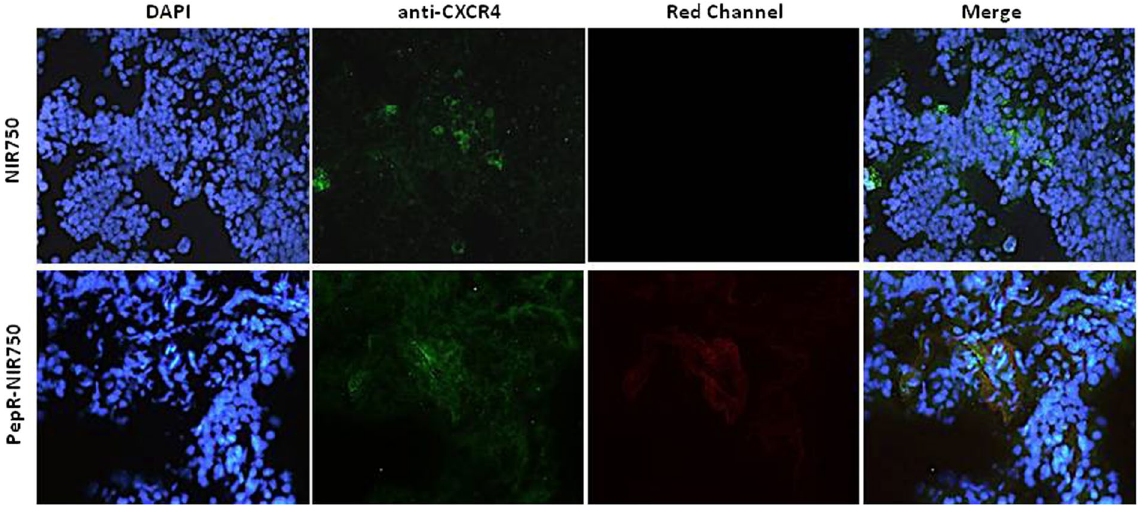
Figure 3. In vivo evaluation of PepR-NIR750 binding to B16-CXCR4 lung metastasis. B16-CXCR4 syngenic tumor model of lung metastases, were obtained by i . v . injection of B16-CXCR4 of CD-1 nu/nu athymic mice. After 3 weeks mice were i . v . injected with PepR-NIR750 (5 nM) or VivoTag-S 750 alone and lungs were stained with a fluorescent CXCR4 antibody (green) and analyzed for PepR-NIR750 (red) staining. Sections obtained from PepR-NIR750 or VivoTag-S 750 -injected mice lungs were imaged at fluorescence microscope Axioscope A.1. Nuclei were stained with DAPI. Merged images of anti-CXCR4 antibody staining and PepR-NIR750 or VivoTag-S 750 alone fluorescence are shown in the last panel. The PepR-NIR750 signal is detected in lung metastasis and co-localizes with anti-CXCR4